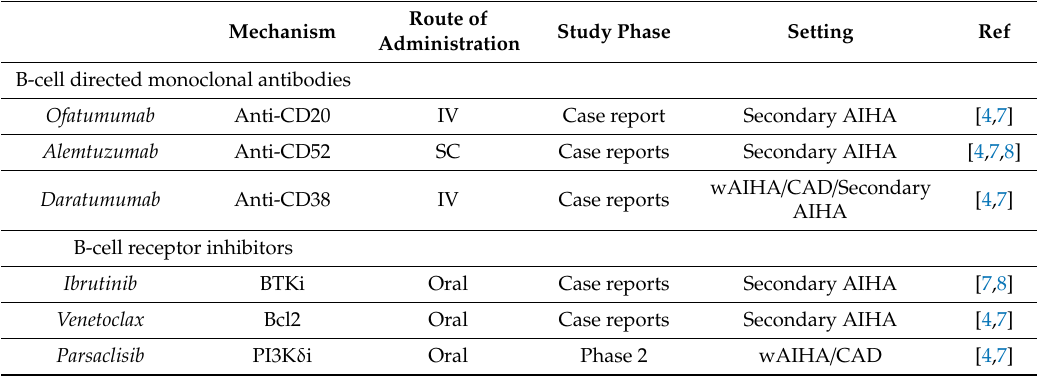
Table 4. New drugs in warm AIHA (wAIHA) and cold agglutinin disease (CAD). Route of Mechanism